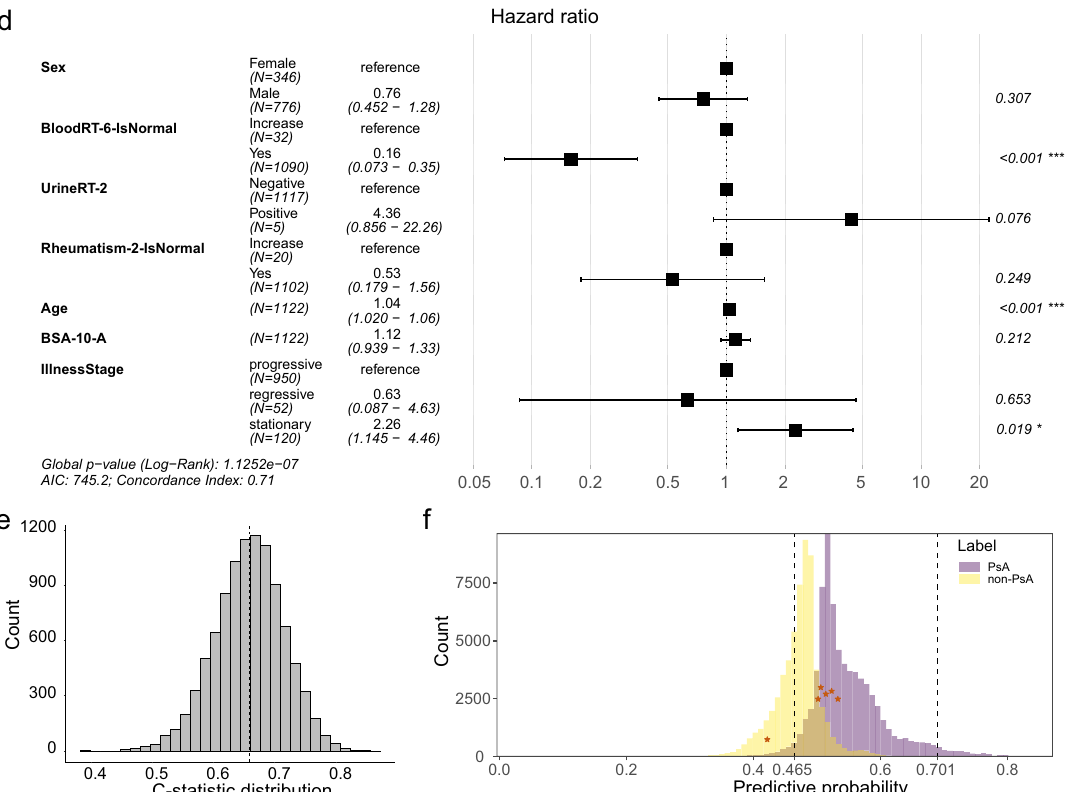
* indicates the standard deviation of each feature importance value.